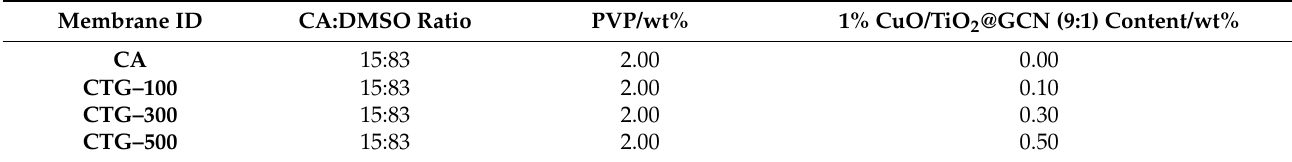
Table 1. Chemical composition of casting solution for fabrication of CuO/TiO 2 @GCN. Membrane